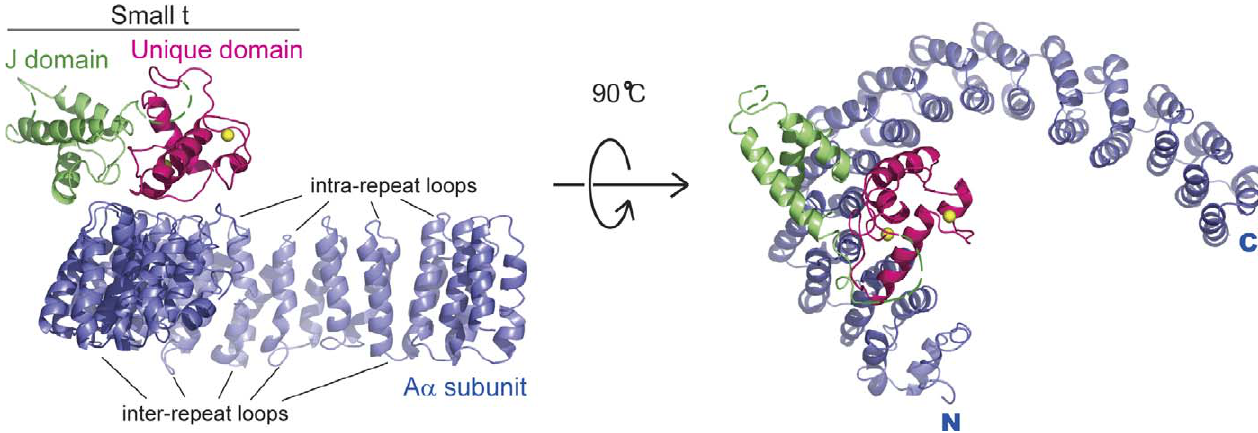
Figure 1. Overall Structure of SV40 ST in Complex with the A Subunit of PP2A A cartoon illustration of the ‘‘ front ’’ and ‘‘ top ’’ views of the PP2A A subunit–SV40 ST complex. The scaffold A a subunit of PP2A, the J domain, and the unique domain of SV40 ST are colored blue, green, and magenta, respectively. In addition, two zinc ions in the ST unique domain are yellow. ST interacts with the intrarepeat loops of HEAT repeats 3–7 of PP2A A subunit.